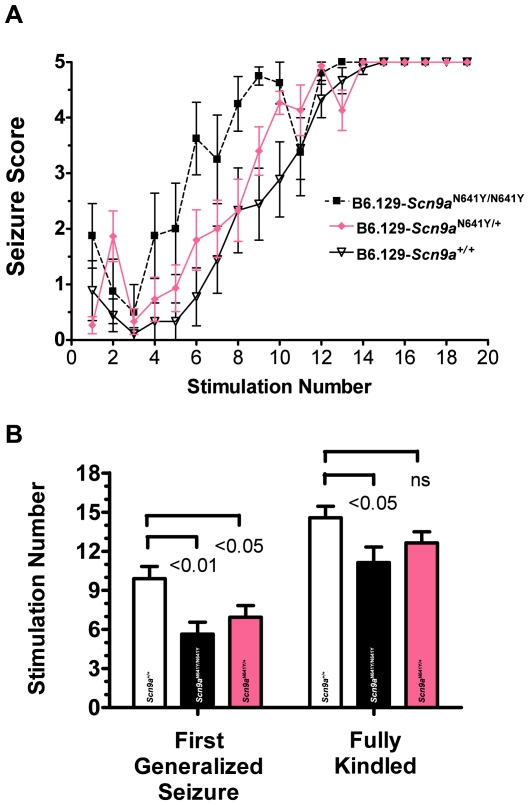
Increased corneal kindling acquisition rates of Scn9a knockin mice compared to wild-type littermate controls.Male N5F2 mice separated by genotype (n = 8–15) were stimulated with corneal electrodes twice daily until four consecutive Racine Stage 4 or 5 secondarily generalized seizures were elicited. The effect of Scn9a-N641Y on kindling acquisition is shown in (A) for B6.129-Scn9a+/+, B6.129-Scn9aN641Y/+, and B6.129-Scn9aN641Y/N641Y mice; results are expressed as the average seizure score per genotype observed after each stimulation. (B) The number of stimulations required to reach the first fully generalized Racine Stage 4–5 seizure, regraphed with p-values from the data in (A), is 9.89±0.93 (B6.129-Scn9a+/+, clear bar), 5.63±0.92 (B6.129-Scn9aN641Y/N641Y, black bar), and 6.93±0.89 (B6.129-Scn9aN641Y/+, pink bar), left panel; the number of stimulations required to reach a fully kindled mouse defined as four consecutive Racine Stage 4–5 seizures, regraphed with p-values from the data in (A), is 14.56±0.88 (B6.129-Scn9a+/+, clear bar), 11.13±1.2 (B6.129-Scn9aN641Y/N641Y, black bar), 12.64±0.86 (B6.129-Scn9aN641Y/+, pink bar), right panel.